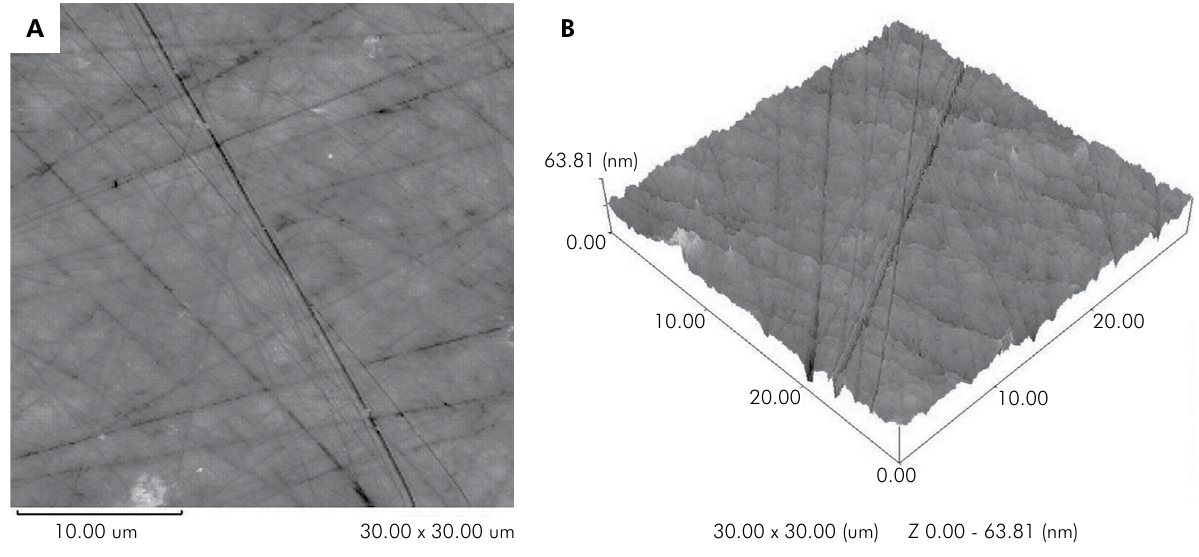
Figure 1. AFM image of enamel surface after erosive challenge and no-varnish application. (A) “Straches” lines are caused by the polishing procedure. (B) Rough surface without protection layer.